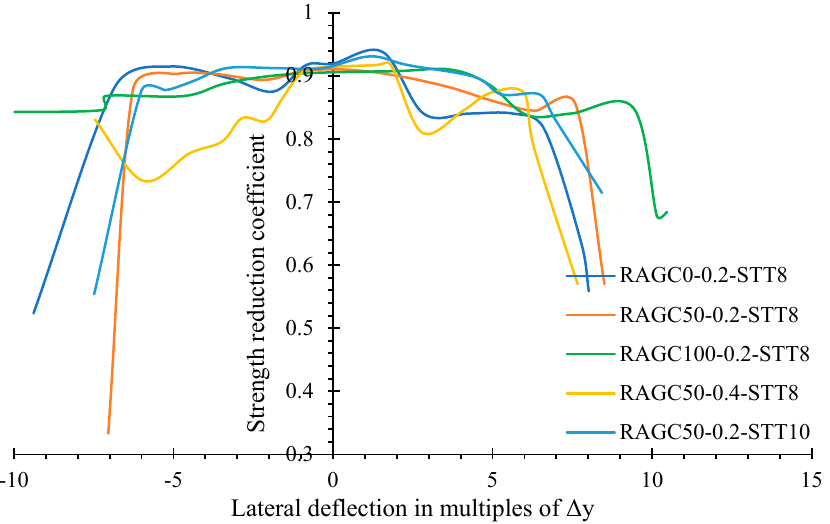
Figure 15. Reduction in load-carrying strength of specimens.